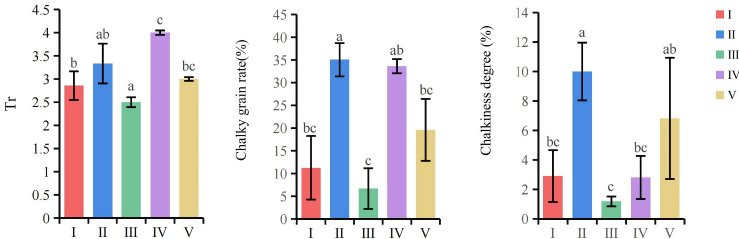
Fig. 5: Appearance Quality performance. Statistical analysis of chalky grain rate, Chalkiness degree and transparency(Tr) based on Cluster